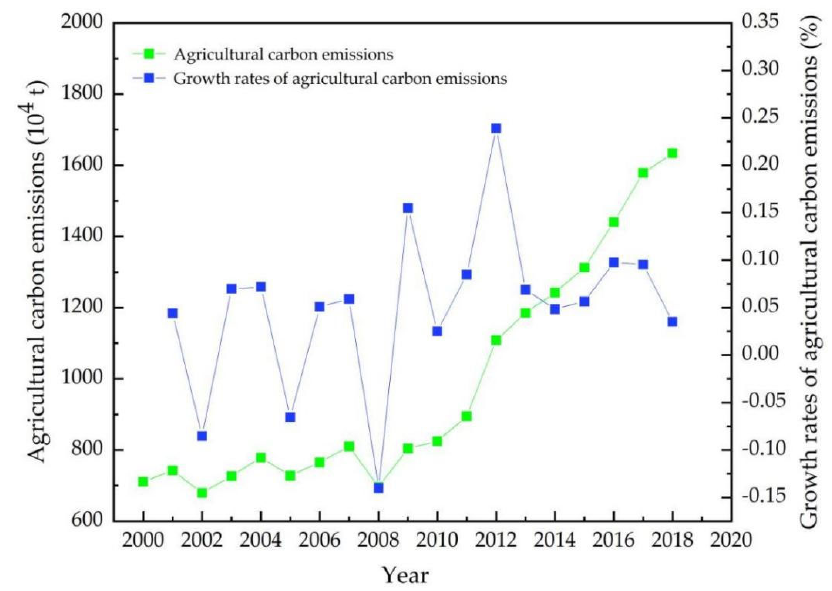
Figure 1. Agricultural carbon emissions in Heilongjiang province (2000–2018).